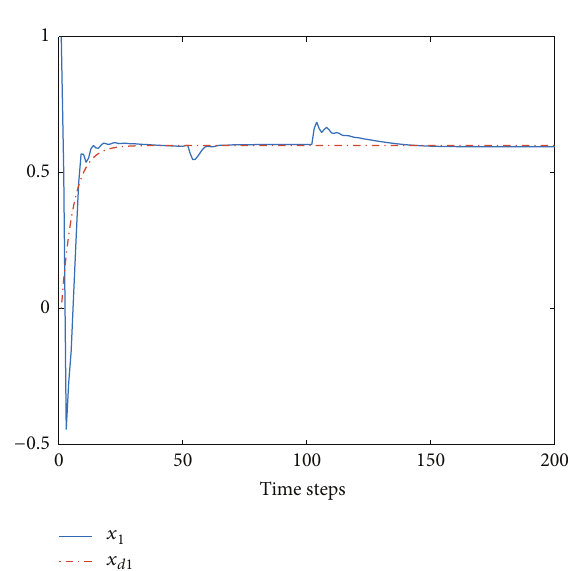
Figure 6: The state trajectory 𝑥 1 and desired trajectory 𝑥 𝑑1